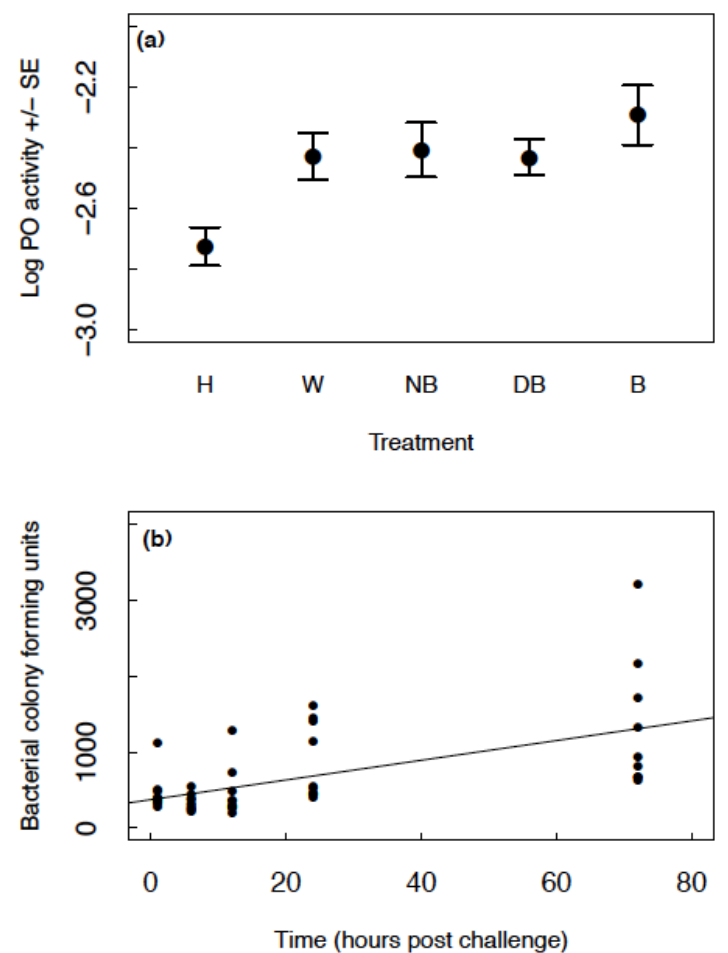
Figure 2. ( a ) The mean raw data for log PO ± SE across the different treatment groups; handled (H), injected with insect ringer’s solution (W), injected with nutrient broth (NB), injected with heat-killed B. subtilis (DB) and injected with live B. subtilis (B); ( b ) The bacterial colony forming units produced from haemolymph samples at time points 1–72 h post infection. The black points show the raw data and the line illustrates the fitted values of the